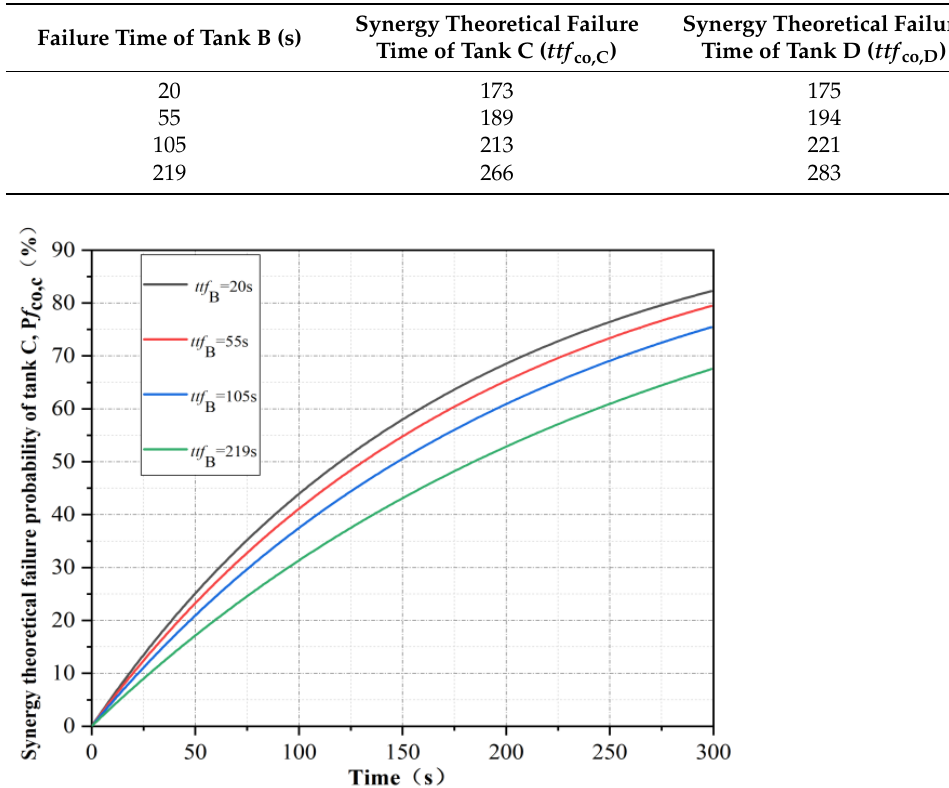
Figure 8. Real-time failure probability of tank C under the synergistic effect of tanks A and B.